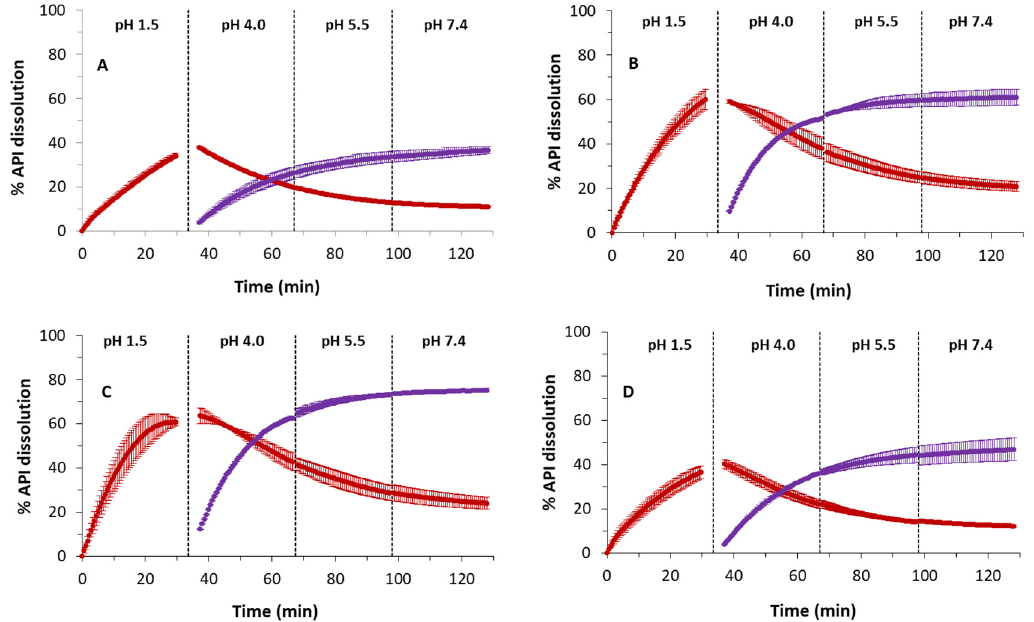
Figure 9. Dissolution profile of AD ( A ) and the AD–Resorcinol (Form I) ( B ), AD–Orcinol ( C ), and AD–Hydroquinone ( D ) cocrystals in a four-pH sectors biphasic test. (•) shows the AD percentage dissolved in the aqueous phase, and (•) the AD percentage dissolved in the lipidic phase.